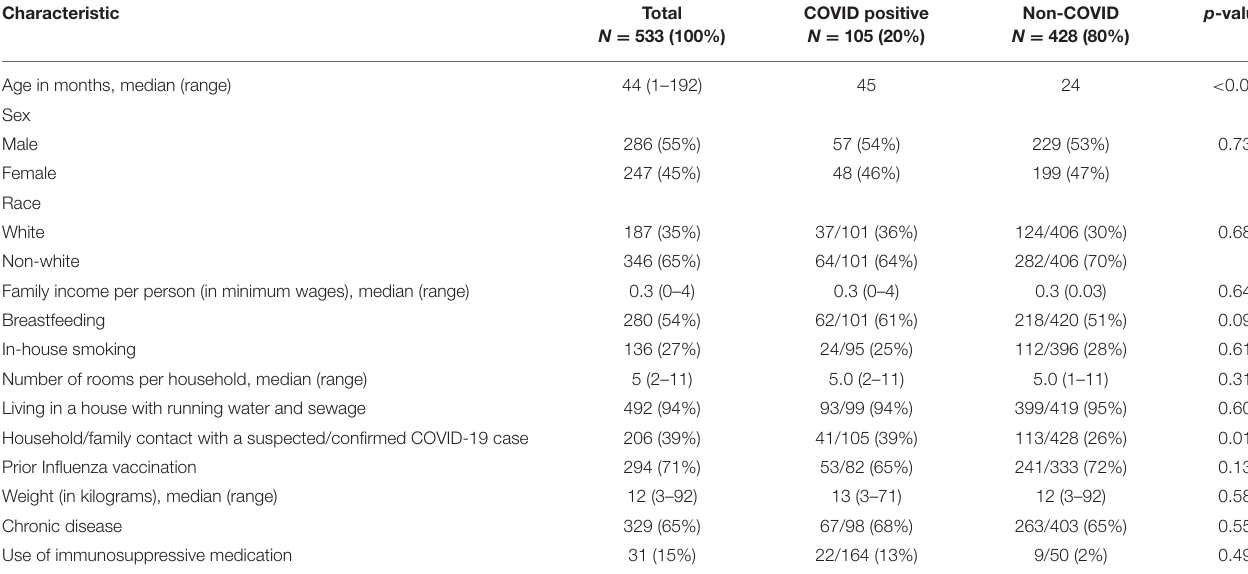
TABLE 1 | Demographic and epidemiological data of pediatric patients hospitalized with suspected COVID-19 diagnosis of both groups. Characteristic Total N = 533